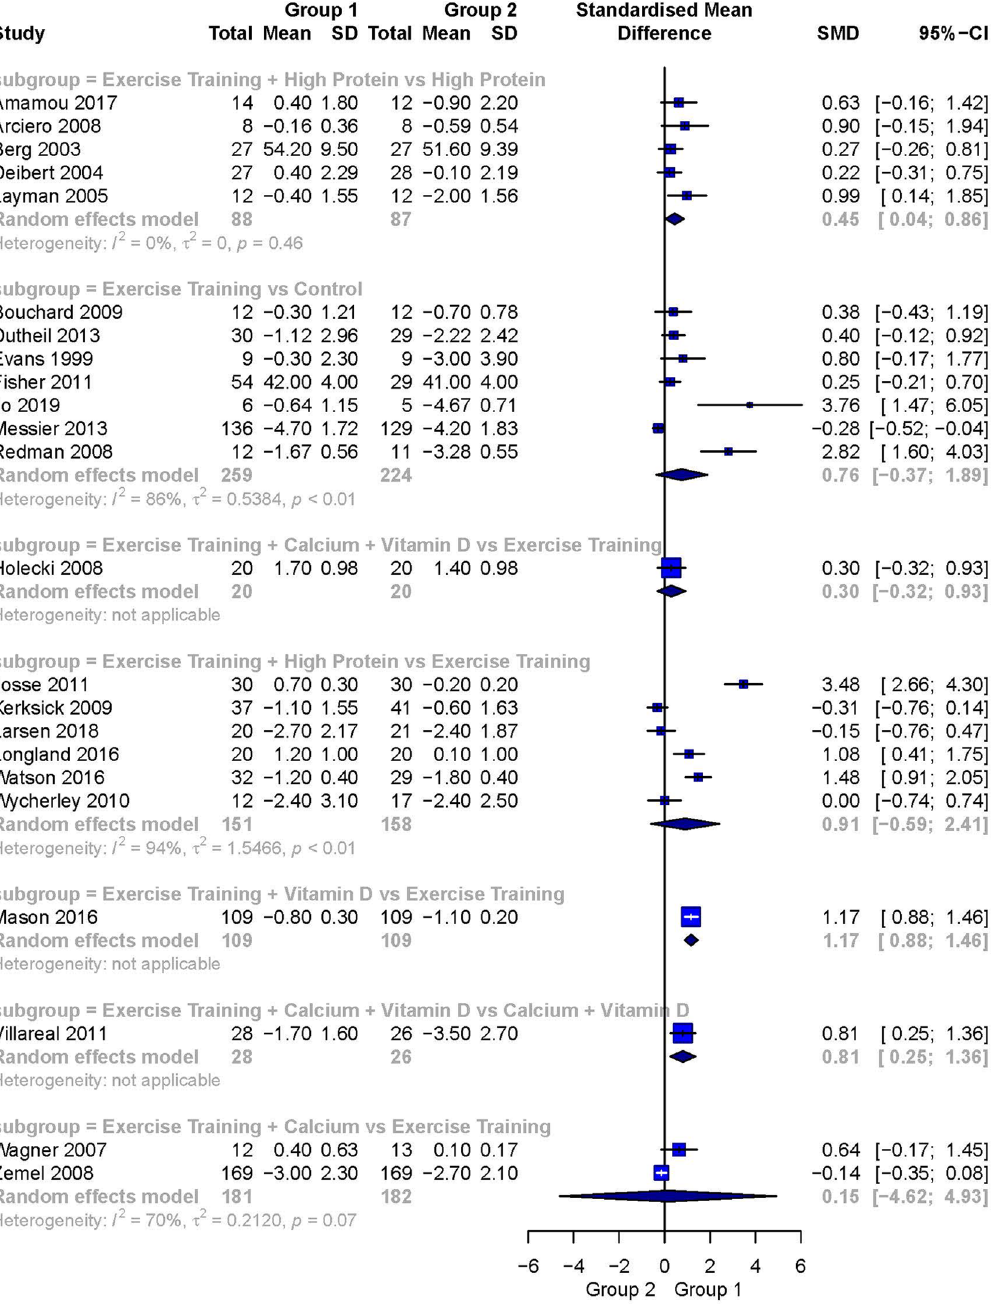
Figure 3. Forest plot of the head-to-head comparisons for the fat-free mass (kg) outcome during diet-induced weight loss. Data are presented as SMDs with 95%CIs. The FFM outcomes are expressed as change scores and final